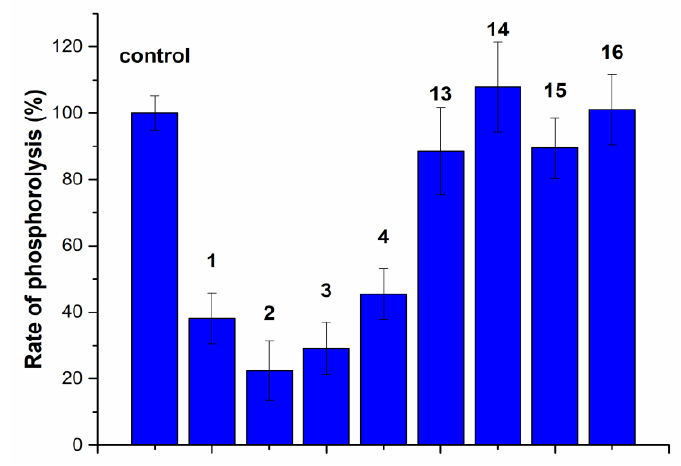
Figure 1. Rate of inosine phosphorolysis for compounds 1–4 and 13–16 .